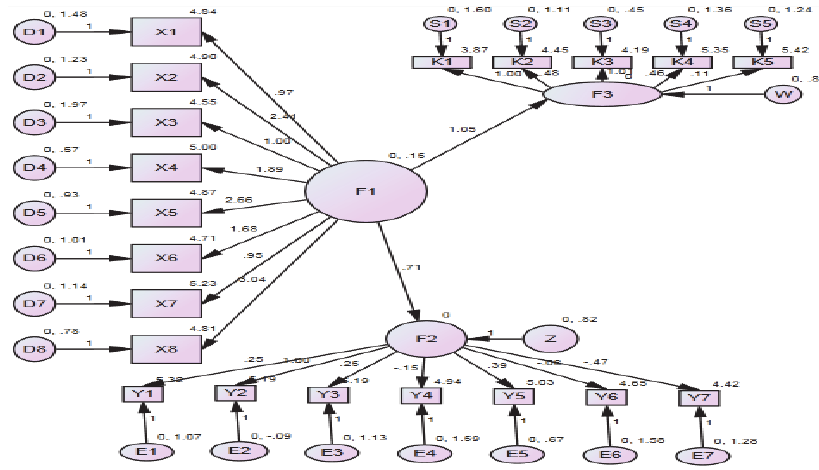
Fig. 2. The results of different factors on blended